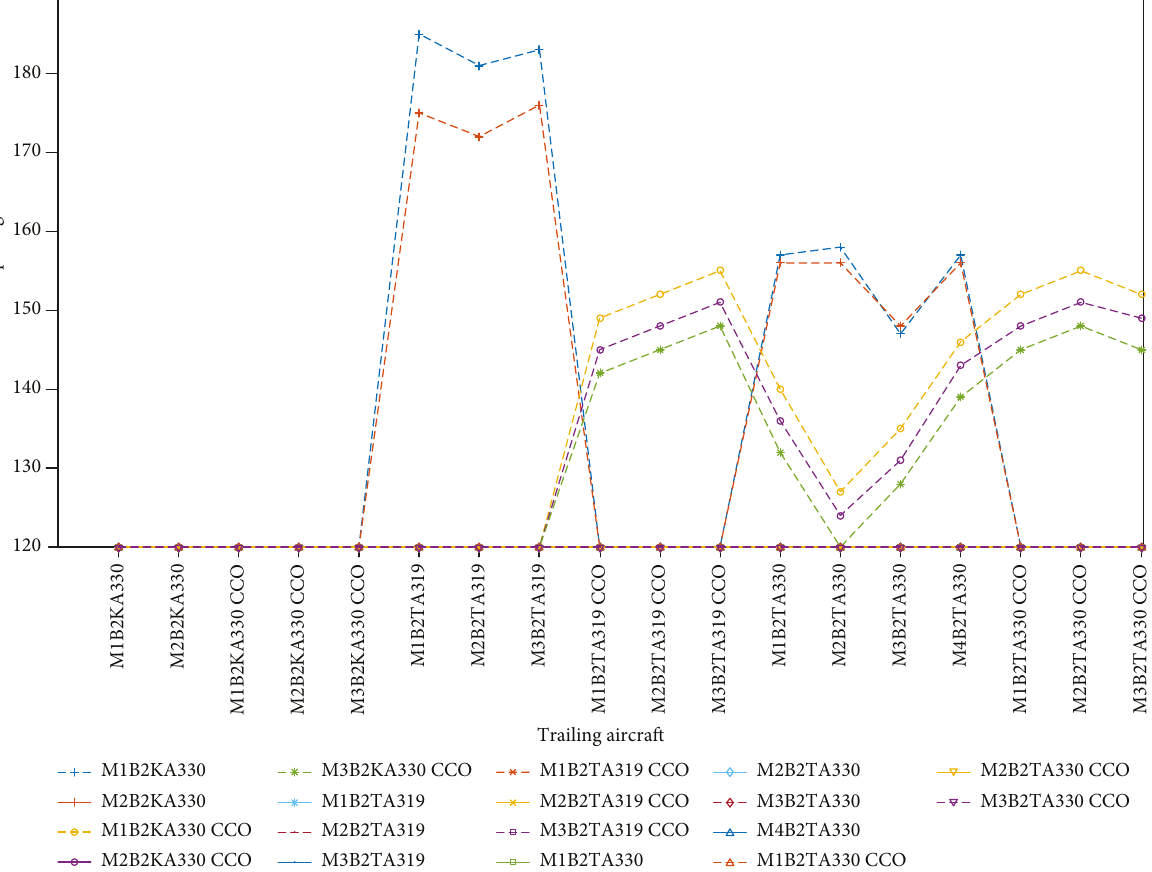
Figure 3: Time separations between aircraft operating BARDI2T/CCS1T and BARDI2K/CCS1K